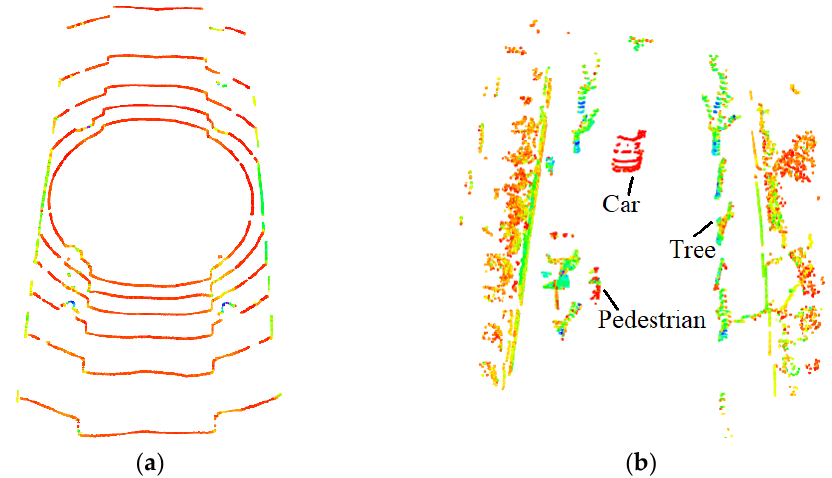
Figure 3. Result of ground segmentation: ( a ) ground point cloud; ( b ) obstacle point cloud.